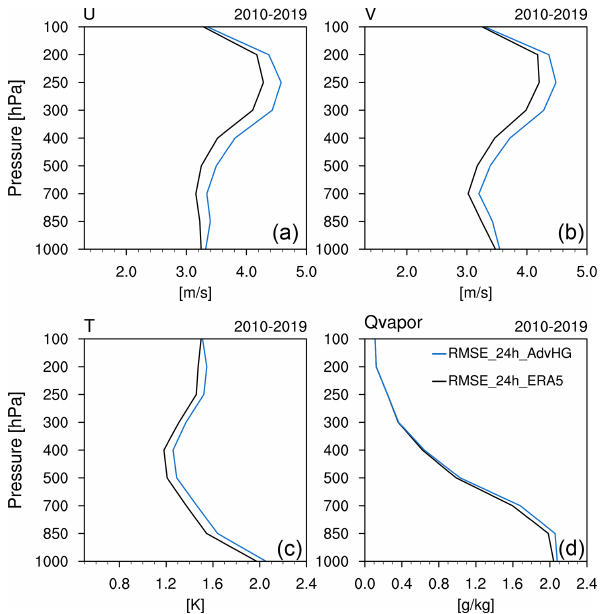
Figure 7. The same RMSEs as in Fig. 6, except for RMSEs of 24h forecast.